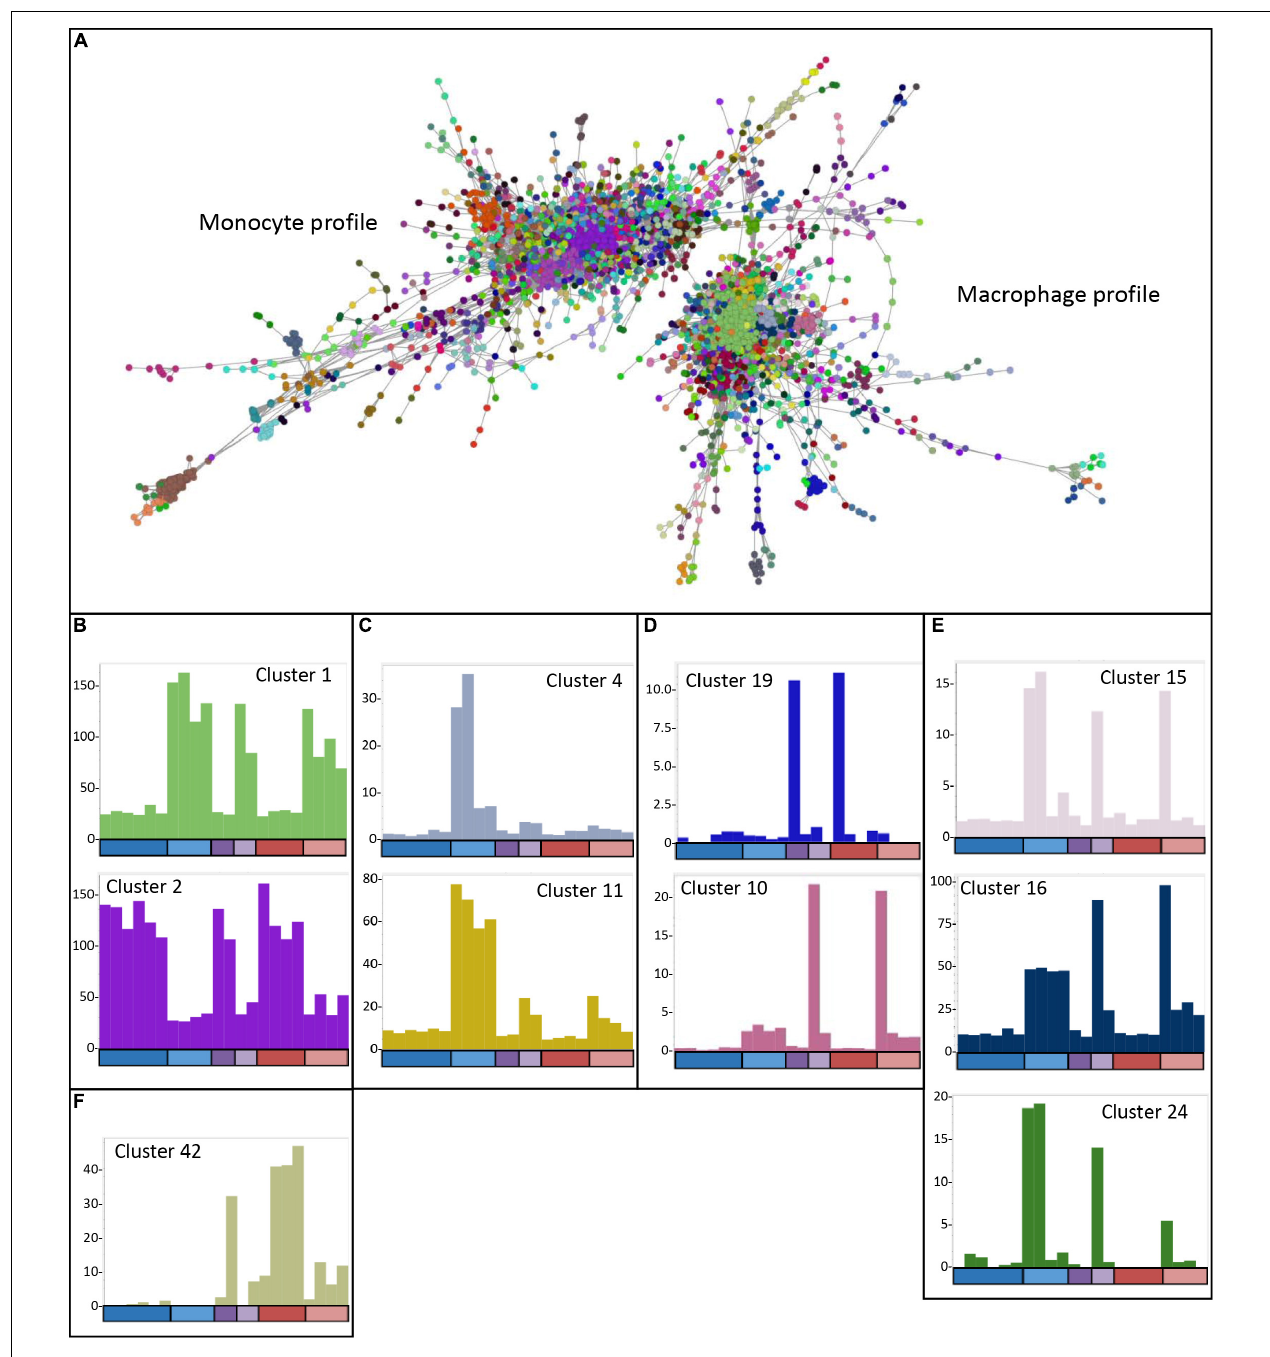
FIGURE 7 | Network analysis of edited cells. (A) Gene-to-gene 2D network graph. Image taken from BioLayout output showing CTSS-CTSS correlations (nodes = CTSS; edges = correlations of ≥ 0.92 between them). The analysis included all four USP16 knockout lines, HetC and HetdE and wild type samples; raw data for wild type are from (Gazova et al., 2020), 0 h and 24 h time points. Nodes in the same cluster have the same color. (B) Average expression profiles for Clusters 1 and 2, showing up- or down-regulation in response to PMA in all cells. (C) Average expression profiles for Clusters 4 and 11 showing very small effect of PMA in the edited homozygous and heterozygous cells. (D) Average expression profiles for Clusters 10 and 19, showing specific expression in Hom1 and its parent HetC at 0 h (cluster 19) or 24 h post PMA treatment (Cluster 10). (E) Average expression profiles for Clusters 15, 16, and 24 showing expression in some or all wild type samples as well as HetC and Hom1. (F) Average expression profile for Cluster 42, showing high expression only in HetdE, Hom2, Hom3, and Hom4. In panels ( B - F) , Y -axis shows the average expression of genes in the cluster in TPM. X -axis shows the samples. The bar along the X axis shows the time point, colored as for Figure 5 : dark colors 0 h, light colors – 24 h after PMA stimulation; blue – wild type, purple – heterozygotes, red – homozygotes. Samples are in the order wild type (6 samples at 0 h and 4 at 24 h), heterozygotes (HetC, HetdE), homozygotes (Hom1, Hom2, Hom3, and Hom4). Columns have the same color as the clustered nodes in panel (A)